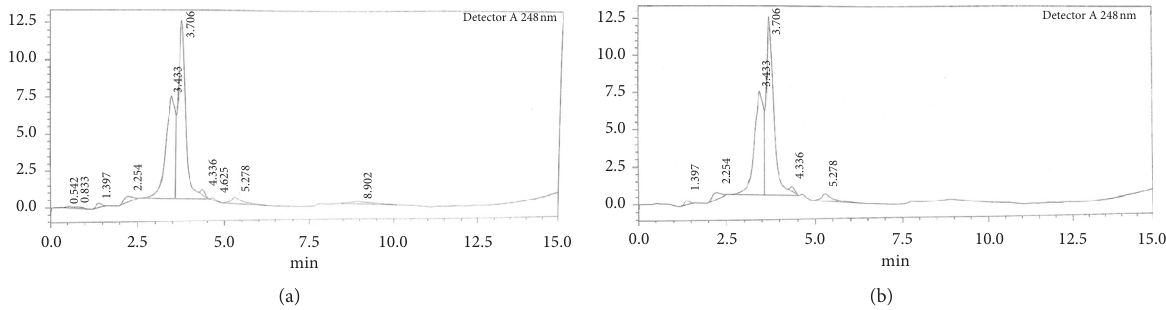
Figure 11: (a) Elution profile of the An-SBR-treated synthetic textile effluent with 500mg/L mixed azo dyes; (b) elution profile of the An- SBR- and MBBR-treated synthetic textile effluent with 500 mg/L mixed azo dyes.